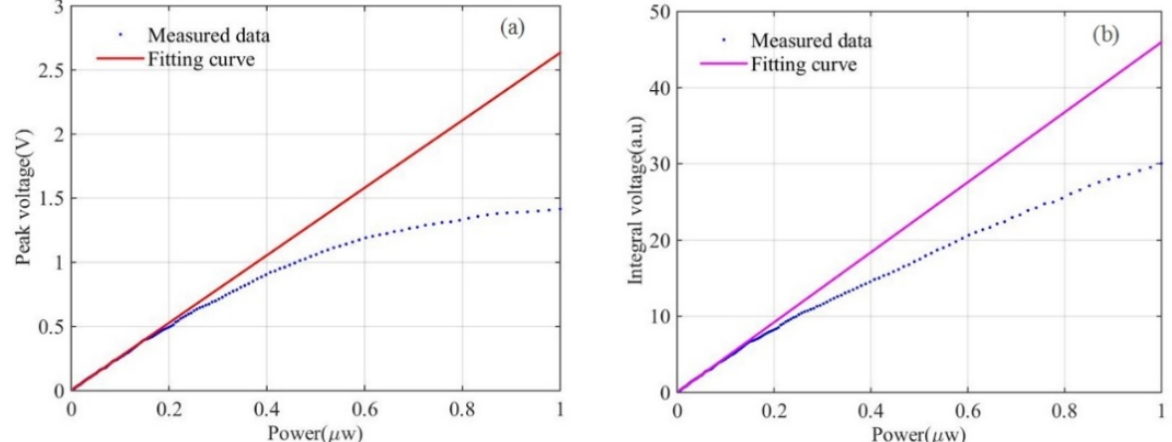
Figure 6. ( a ) The curve of the output peak voltage of the airborne prototype detector with the input power. ( b ) The curve of the output integral voltage of the airborne prototype detector with the input power.